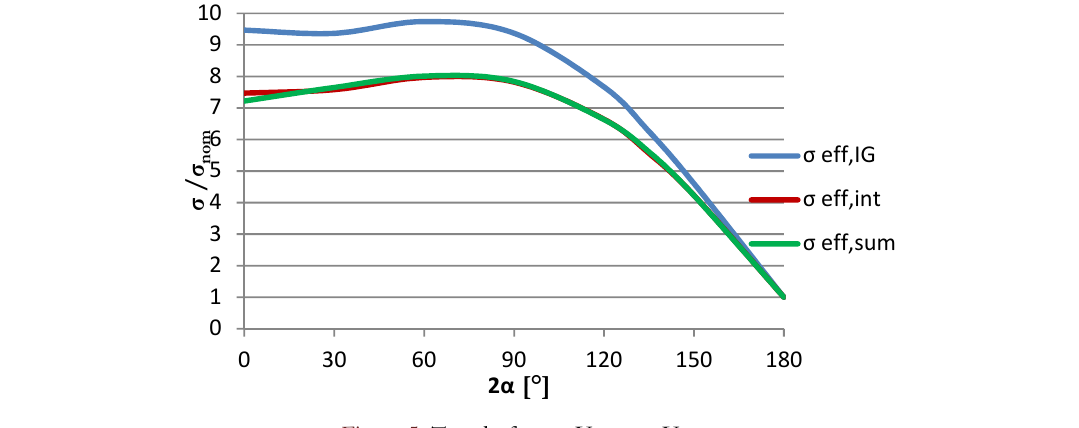
Figure 5: Trend of σ eff,int Vs σ eff,IG Vs σ eff,sum